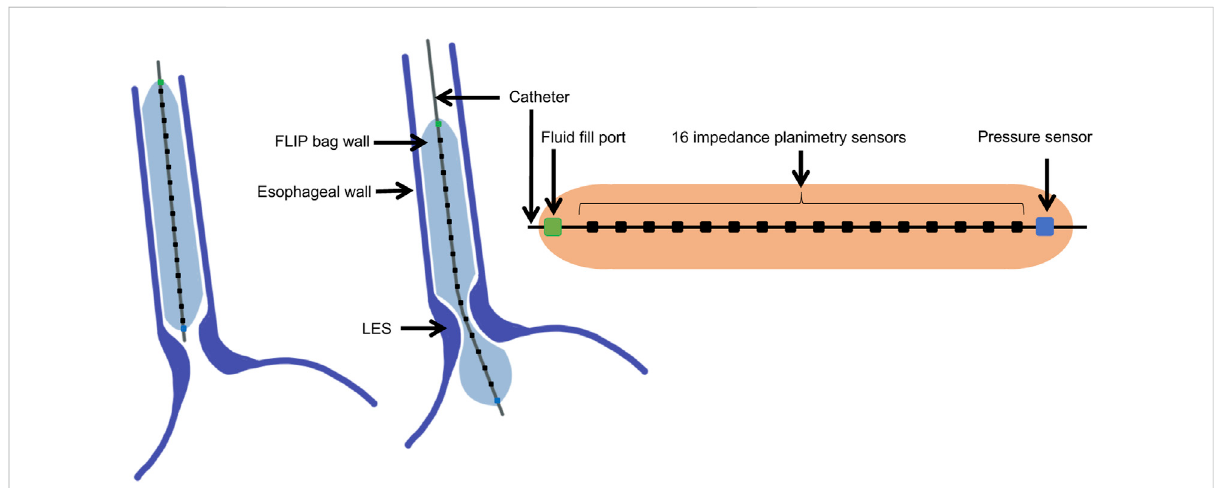
FIGURE 1 DiagramshowingtheFLIPbagandcatheterassemblyplacedwithintheesophagus,passingthroughtheLESornot.Thebagusedinthisstudyis 16 cm long and 22 mm diameter. The catheter measures CSA at 16 location and one distal pressure measurement at each time